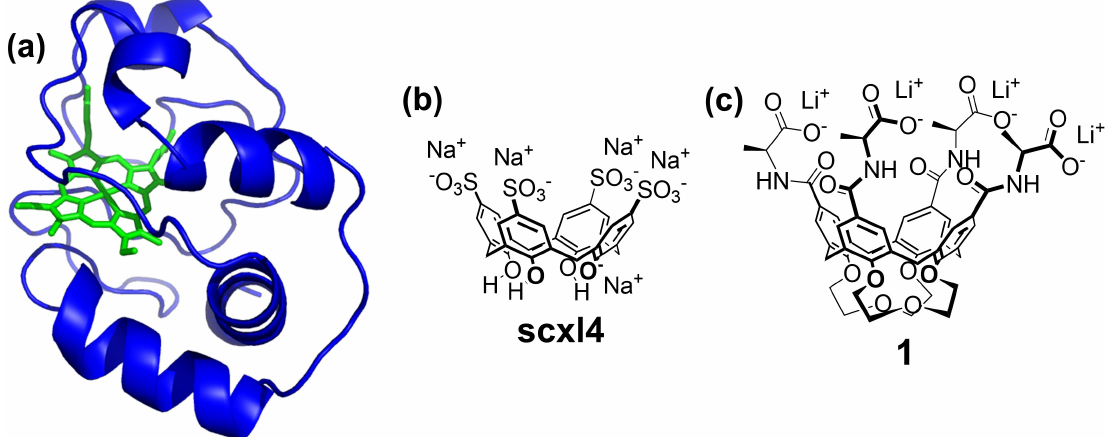
Figure 1. ( a ) Cartoon representation of cytochrome c , with the heme group and the protein backbone colored green and blue, respectively. ( b ) Tetrasulfonato-calix[4]arene sclx 4 that yielded the first cocrystal with this protein [18]. ( c ) Tetra-alanino-calix[4]arene-biscrown-3 1 studied in this work.